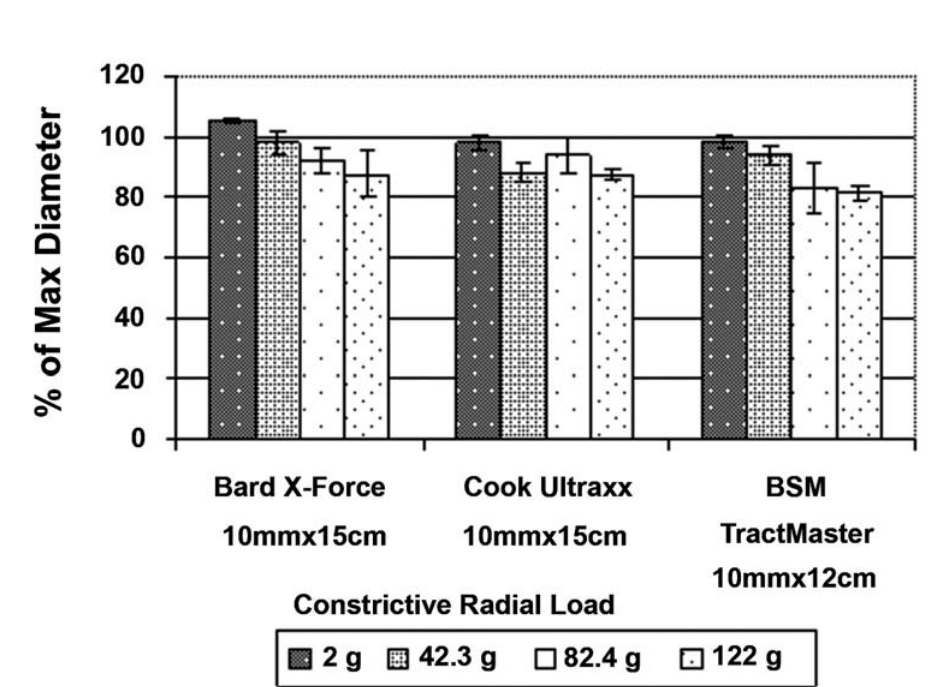
Figure 3 – Balloon dilation at 10 ATM.